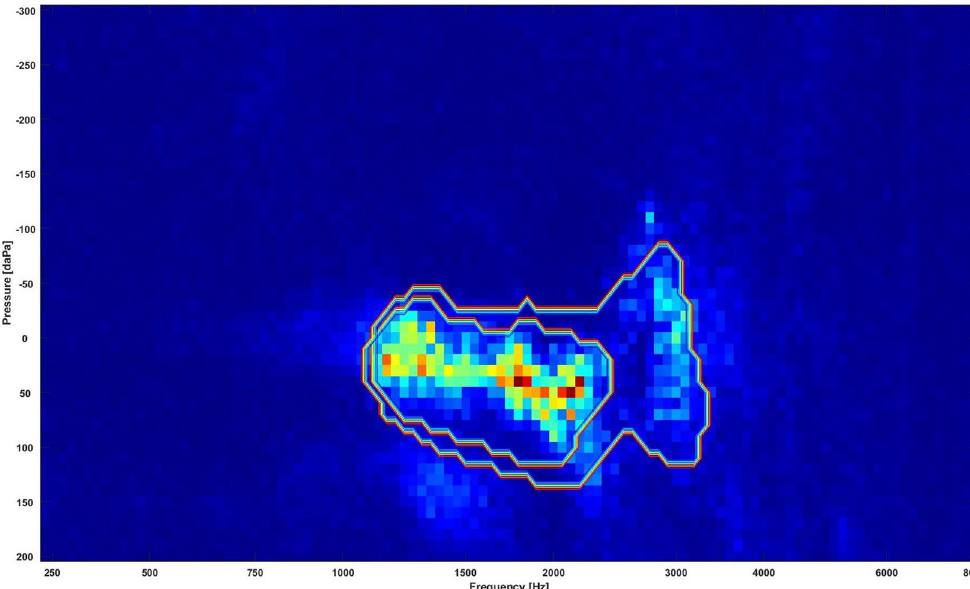
Figure 6. The combination of the regions extracted by RF and contours of extracted regions by the significance test, where the inner contour contains the 5% most significant points (273 points) and the outer contour the top 10% most significant points. Bright regions are the key regions extracted by the RF. The inner circle highlights the statistically significant area that contains 273 points with the lowest p values (273/5457, 5.0%). The outer circle features the statistically significant area that is comprised of points with the 546 lowest p values (546/5457,